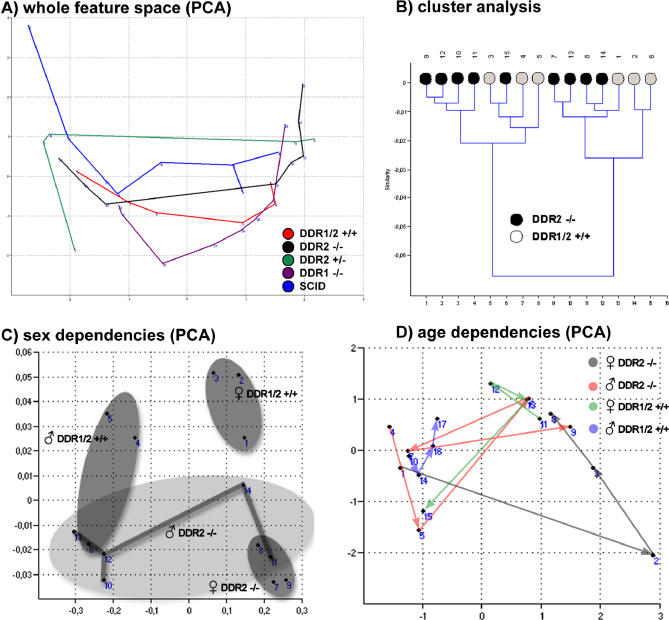
Statistical Evaluation of the Generated 34-D Skull-Shape Features(A) A scatter plot is demonstrated for the two main components of the PCA-transformed 34-D feature space of all skull-shape features. The samples for each mice strain are interconnected with lines. The clusters are strongly overlapping, and in this case the two dimensional subspaces are not linearly separable.(B) A further cluster analysis for DDR2−/− and DDR1/2+/+ mice based on the Euclidean distance between the feature vectors does not separate the two groups.(C) PCA-transformed skull-shape features of a subset of age-matched DDR1/2+/+ and DDR2−/− mice with different sex are well clustered according to their sex for DDR1/2+/+ and the female DDR2−/− mice. The male DDR2−/− mice are widely separated resulting in overlaps with their females.(D) PCA of DDR2−/− and DDR1/2+/+ mice that were separated in male and female are illustrated. Sample points of each group are connected with arrows in the direction of increasing age. No correlation between age and feature vector was depicted.